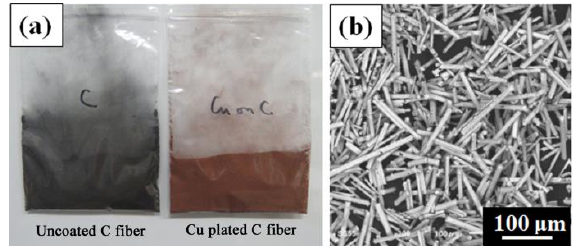
Figure 10. ( a ) External photo and ( b ) SEM image of the carbon fiber plated with copper.